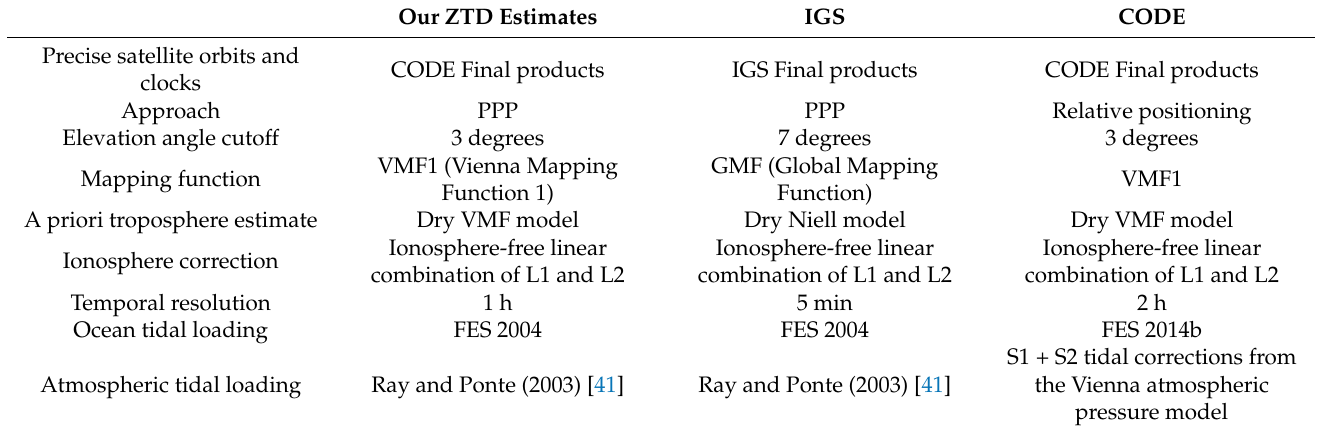
Table 1. Data processing strategies of our ZTD estimates and IGS/CODE tropospheric